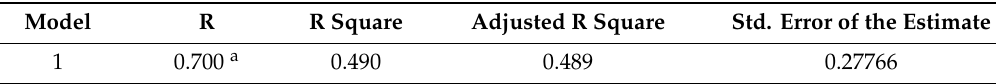
Table 4. Model summary.